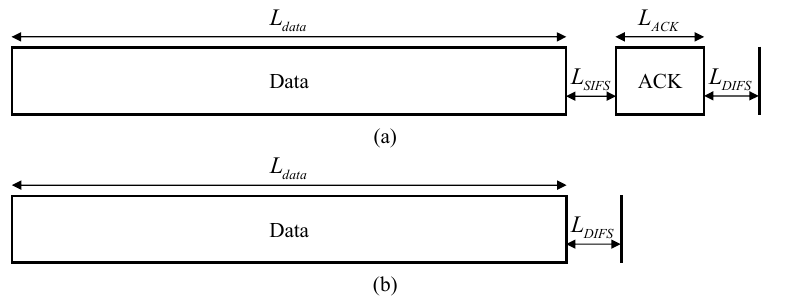
Figure 4. Timing diagram: ( a ) successful transmission, ( b ) collision.